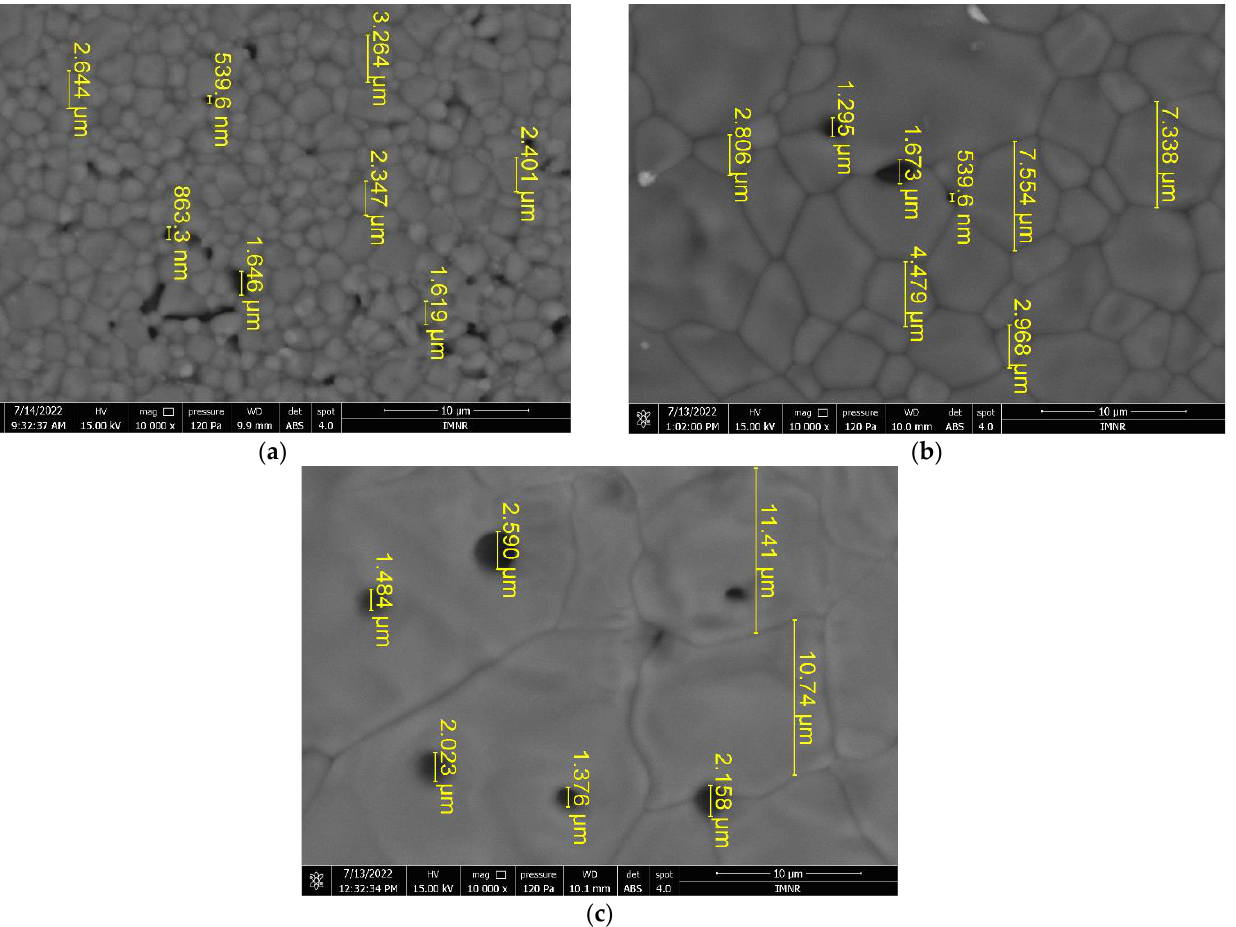
Figure 6. SEM images at 10 μm scale bar, 15 kV voltage , and 10 kX magnification for HAp specimens sintered at: ( a ) 1200 °C/180 min; ( b ) 1300 °C/120 min; ( c ) 1400 °C/120 min.